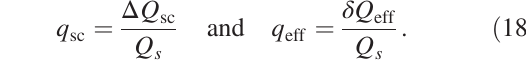
1 , A σ 0 ¼ 0 , eff ¼